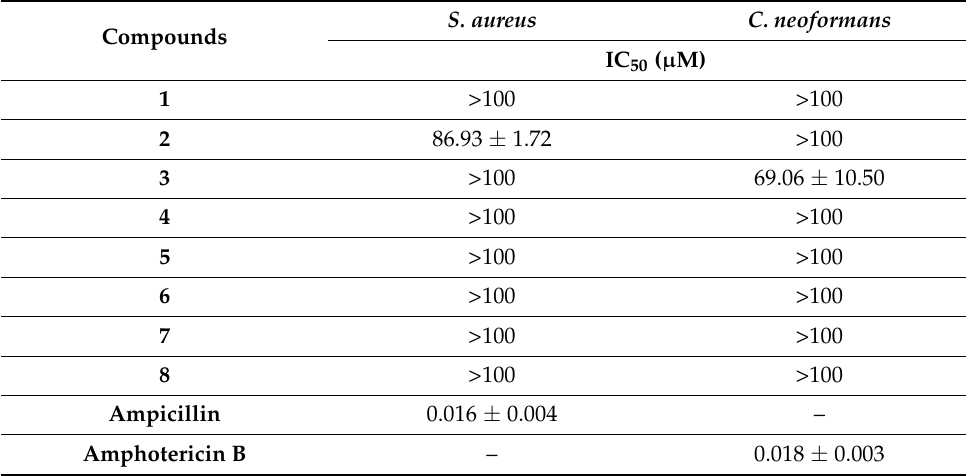
Table 3. Anti-microbial inhibitory activities of compounds 1 – 8 .